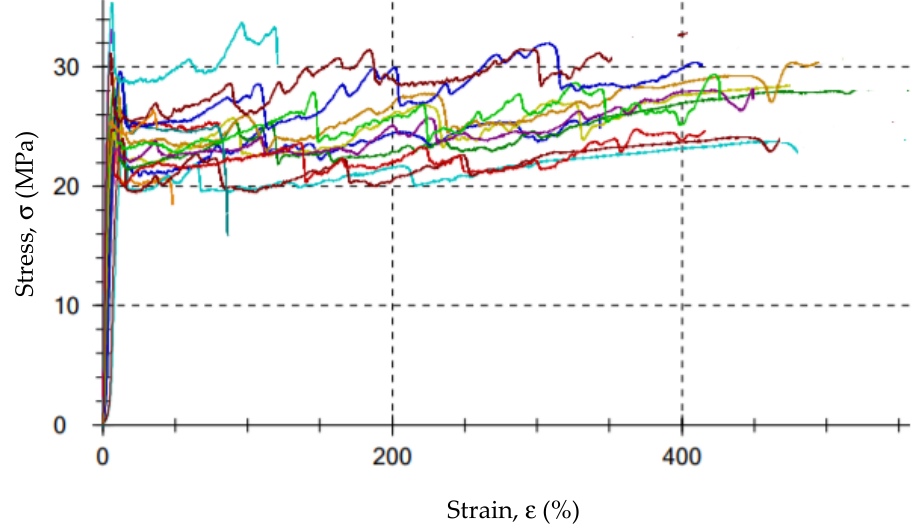
Strain, ε (%) Figure 8. An example of the stress–strain diagram for a selected series of samples. The averaged values of the stresses at break for the tested areas (L, R and C ac- cording to Figure 2) of the CT1 and CT2 cooling towers are shown in Figures 9 and 10. blocks. The presented samples were compared to the reference samples (stored, obtained from the same batch of